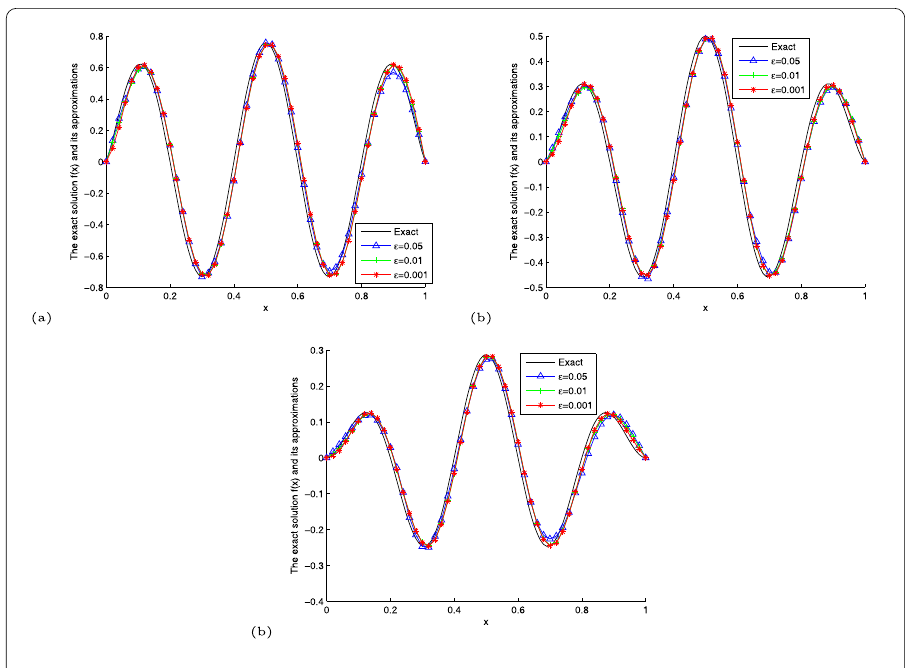
Figure 1 The exact and regularized terms given by the a posteriori parameter choice rule for Example 1: (a) α = 0.2, (b) α = 0.5, (c) α = 0.9.